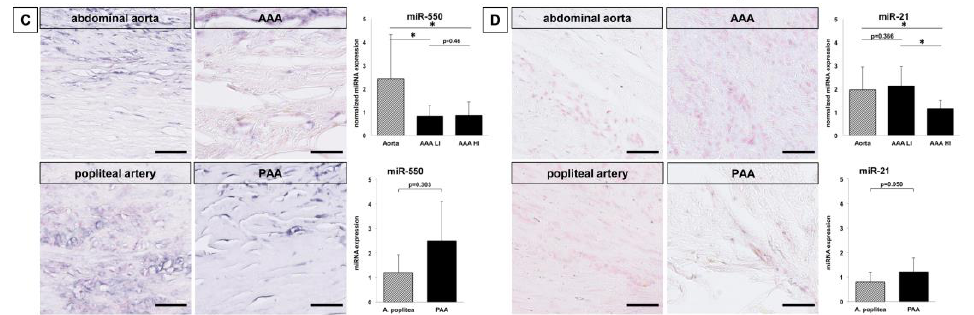
Figure 2. miRNA expression in aneurysm disease: ( A ) miR expression in abdominal aortic aneurysm (AAA), PAA and their respective control tissues normalized to endogenous controls U6 and RNU48 show significant down-regulation for miR-362, -19b-1, -194, -769, -21 and -550 in AAA and down-regulation for miR-19b-1 and -769 in PAA. miR-362 and -194 show no difference and miR-550 and -21 are up regulated in PAA. This is more obvious on the log 10 fold changes, which highlights the differential regulation of miR-550 and -21 between AAA and PAA; ( B ) Both miRs are located to the VSMCs of the intima/media of the vessel and aneurysm respectively and both show enrichment in PAA in comparison to popliteal artery and AAA/control artoa; ( C , D ) While miR-550 is down-regulated in AAA regardless the grade of inflammation, miR-21 shows even up regulation in lower inflammatory specimen compared to high inflammation and control tissue. ( p = probability; * = p < 0.05; magnification 40×; scale bar 100 µm).